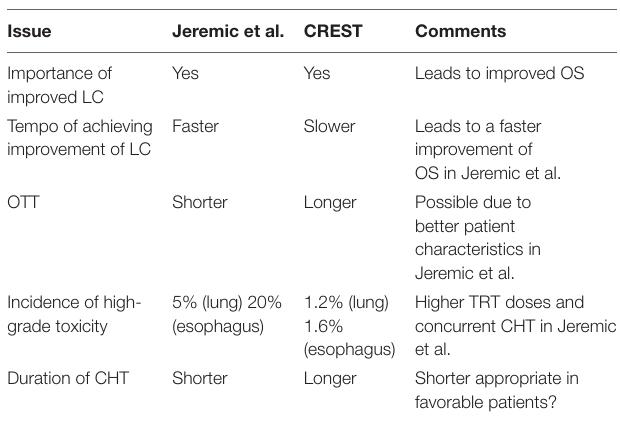
TABLe 2 | Outcomes.